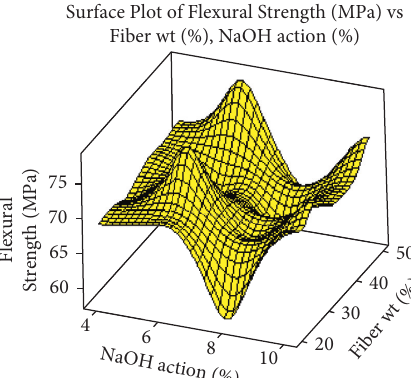
Figure 8: Flexural strength: surface plot of fiber weight percentage and NaOH